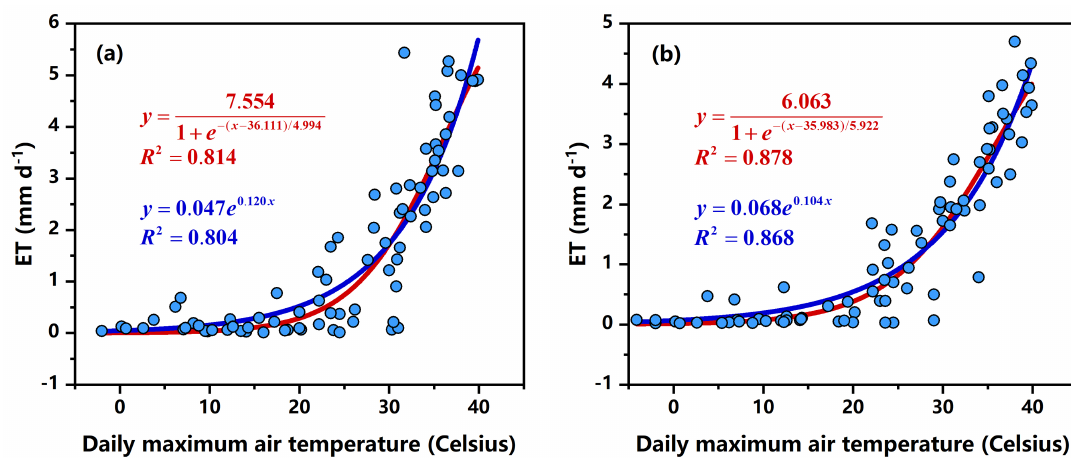
Figure 3. Regression of ET as a function of daily maximum air temperature for the Tamarix site ( a ) and the Populus site ( b ). The red and blue lines are the fitted lines, using a logistic function and an exponential function,